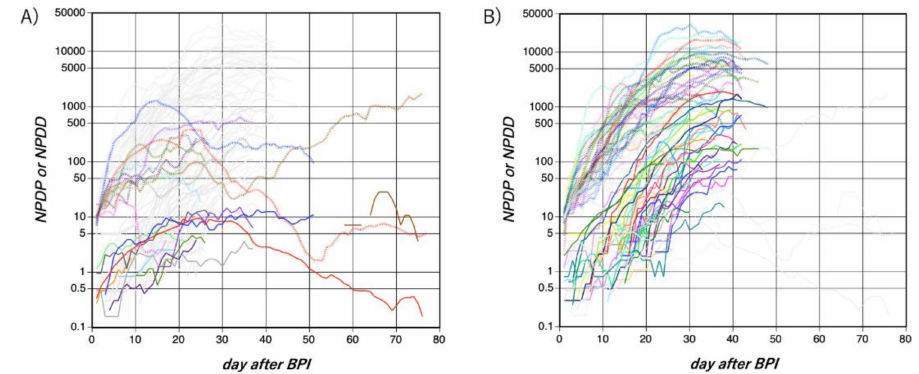
Figure 1. Time courses of NPDP and NPDD after BPI by novel coronavirus diseases 2019 (COVID-19) in Asian countries (except for the Middle East. Panel ( A ) and non-Asian countries (Panel ( B )). The upper dotted lines and lower solid lines represent NPDP and NPDD, respectively. The colors of NPDP and NPDD correspond to each country. Lines in very light gray indicate lines in non-Asian and Asian countries in Panels A and B, respectively, for comparison. Refer to Figures 2 and 3 to identify each country. NPDP: number of population-adjusted daily test-positive cases. NPDD: number of population-adjusted daily deaths. BPI: beginning of the test-positive cases